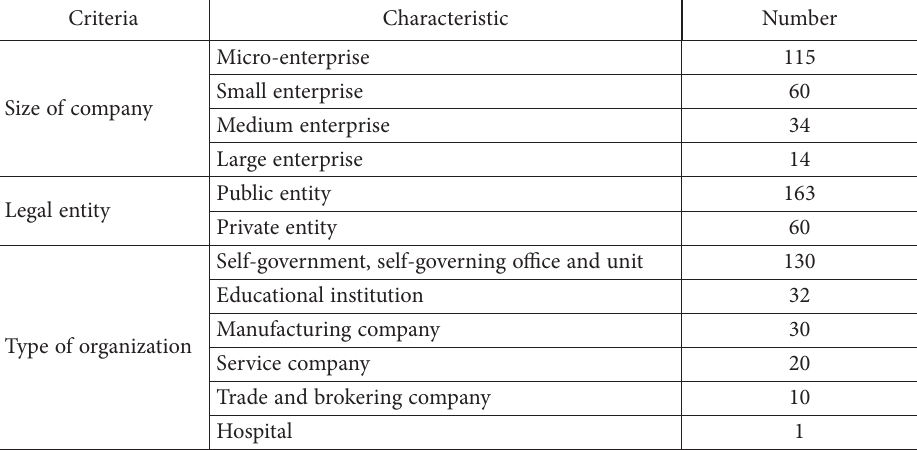
Table 1. Information about organizations